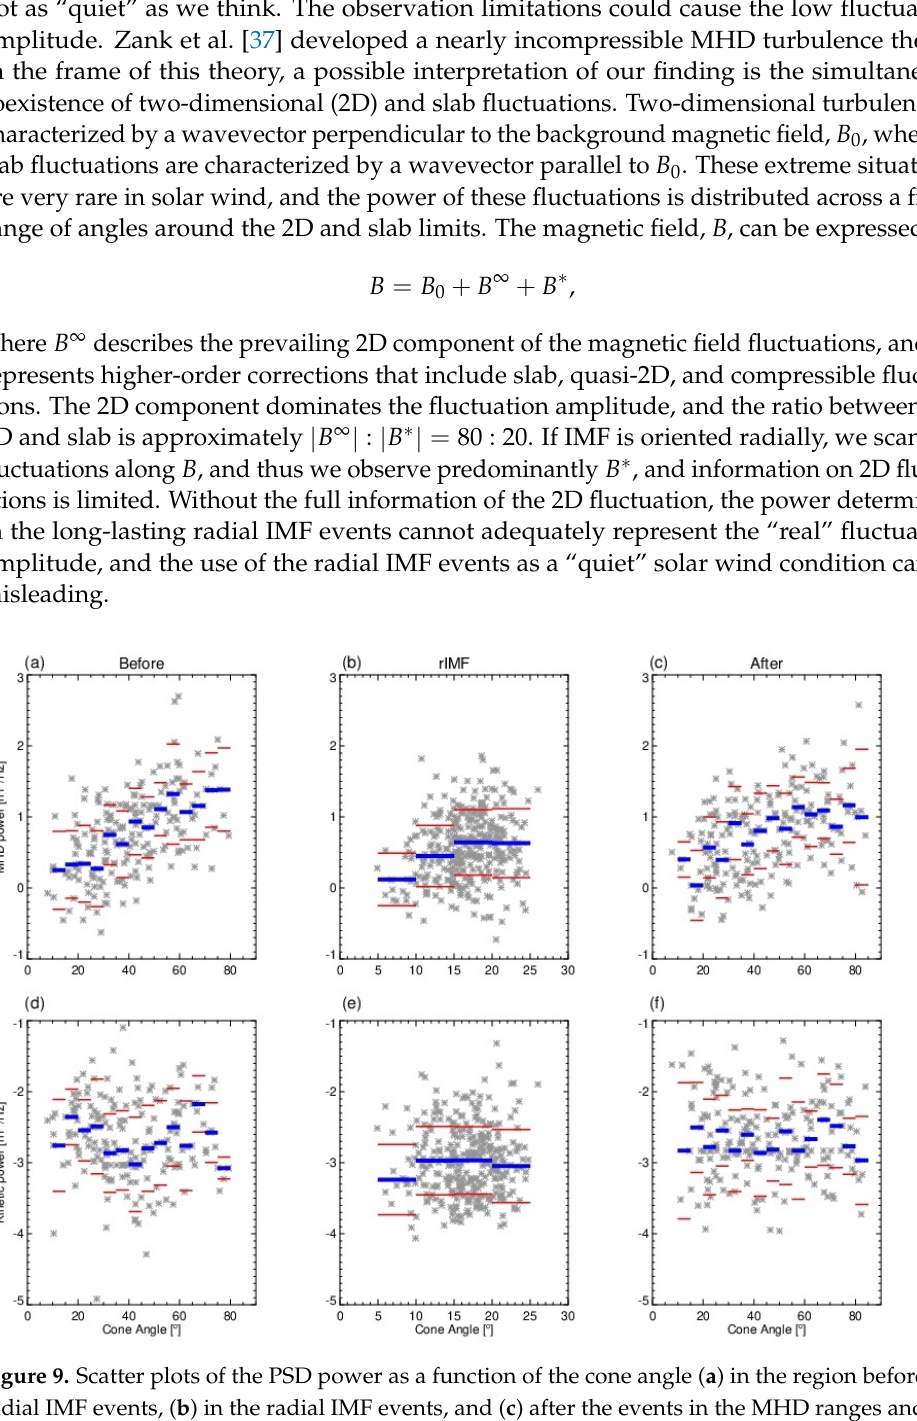
Figure 10. Scatter plots of the PSD slopes as a function of the cone angle with the same format as Figure 9: ( a ) in the region before the radial IMF events, ( b ) in the radial IMF events, and ( c ) after the events in the MHD ranges and the same plots ( d ) in the region before the radial IMF events, ( e ) in the radial IMF events, and ( f ) after the events in the kinetic ranges.